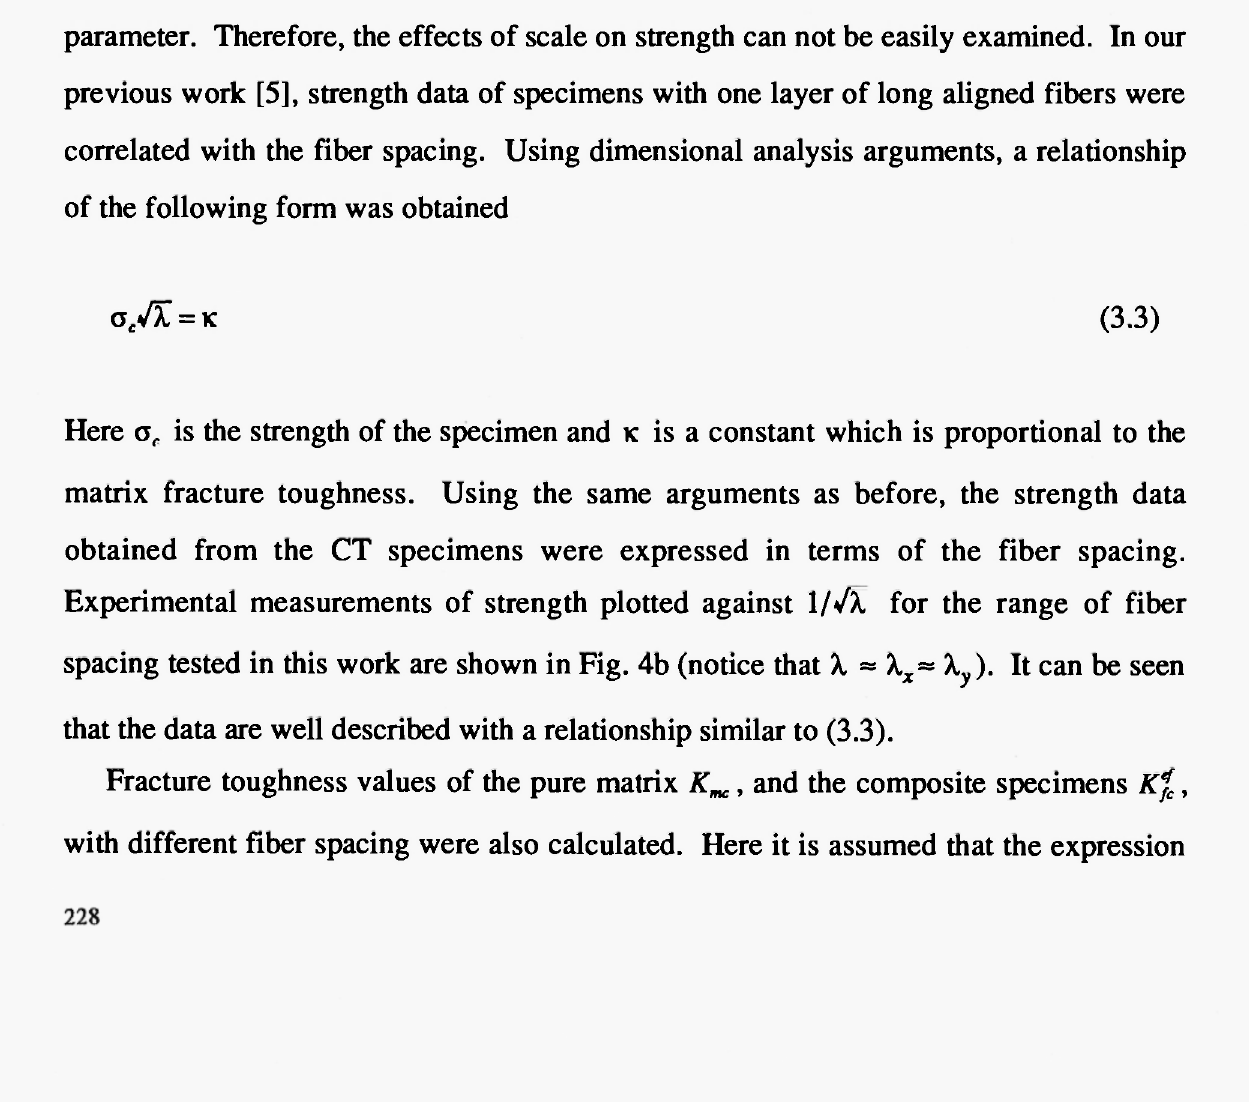
Fig. 4: Strength values σ , (a) as a function of fiber volume fraction, (b) correlated Λ with